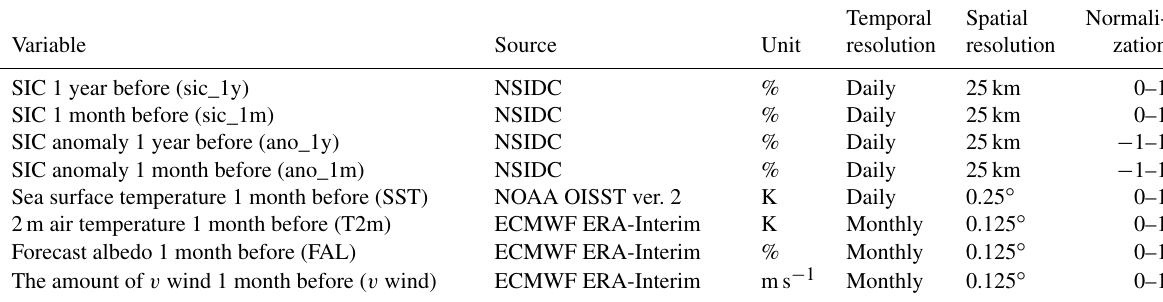
Table 1. The specifications of the eight predictors used to predict short-term SIC in the study. Temporal Spatial Normali- Variable Source Unit resolution resolution zation SIC 1 year before (sic_1y) NSIDC Daily 25km